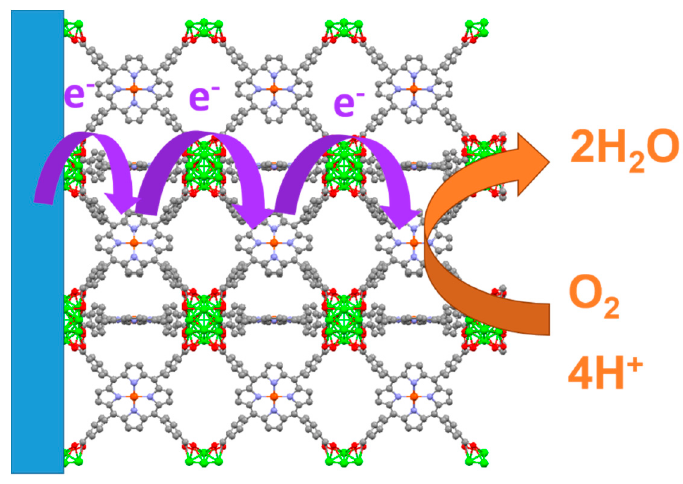
Figure 7. The use of a porphyrinic Zr-MOF (metal–organic framework) PCN-223(Fe), for electrocatalytic oxygen reduction [110]. Lime green: Zr; red: O; grey: C; light slate blue: N; orange: Fe. Hydrogen atoms are not shown for clarity.